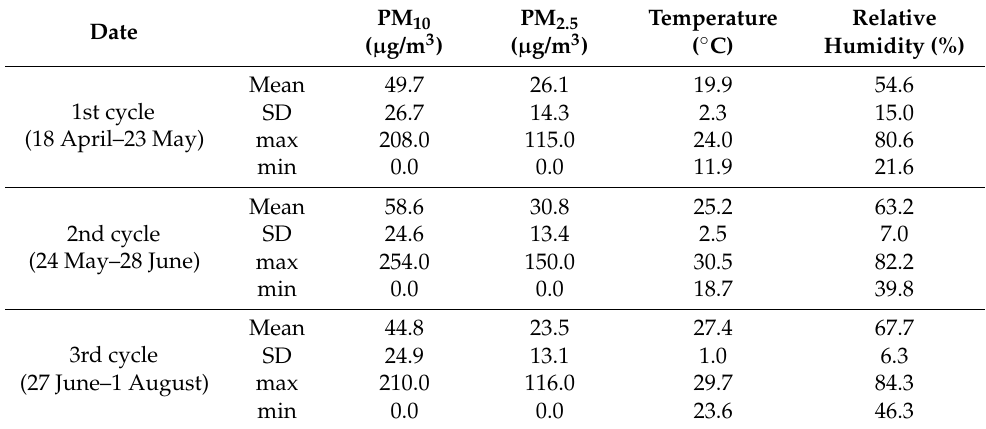
Table 3. Indoor air quality, at each experiment cycle, in the area where the vegetation biofilter was installed.